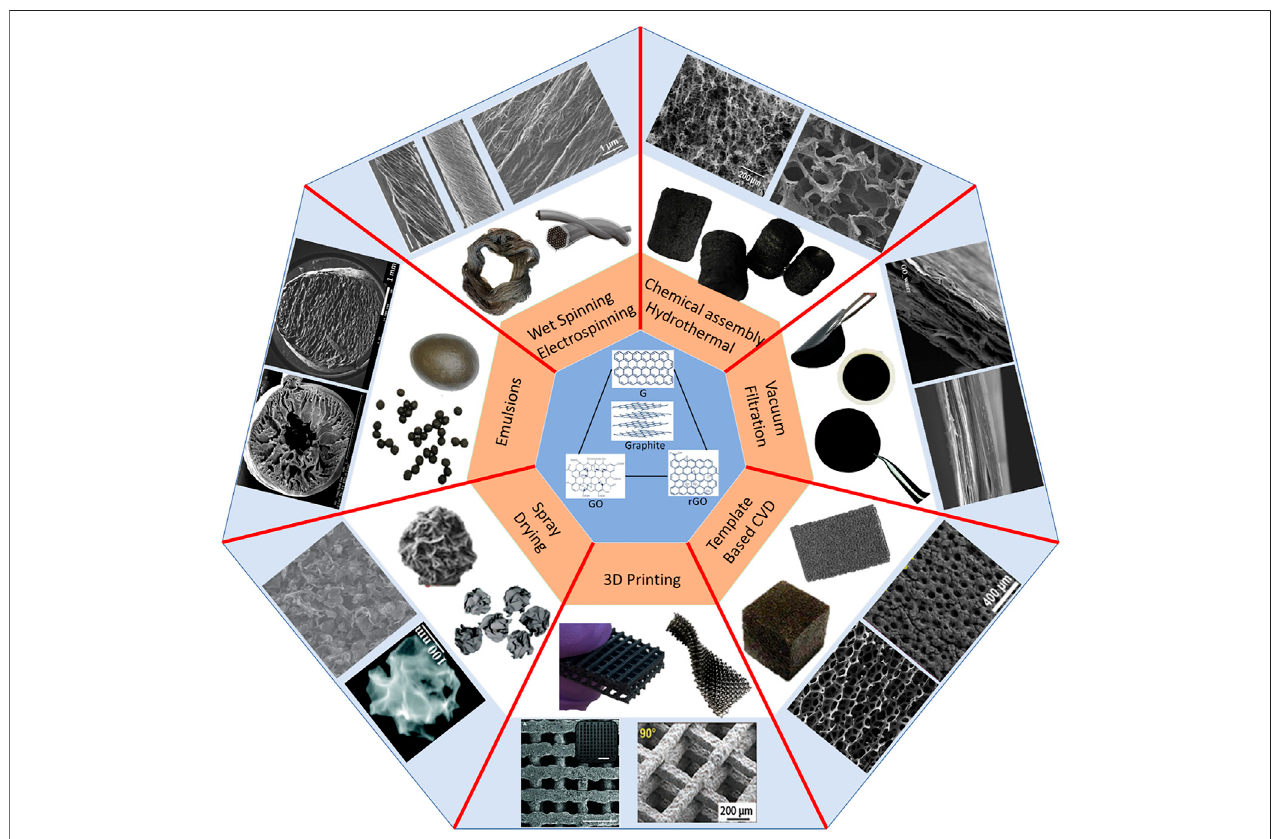
FIGURE 1 | Self-assembly of 2D graphene-based nanosheets into 3D macrostructures.